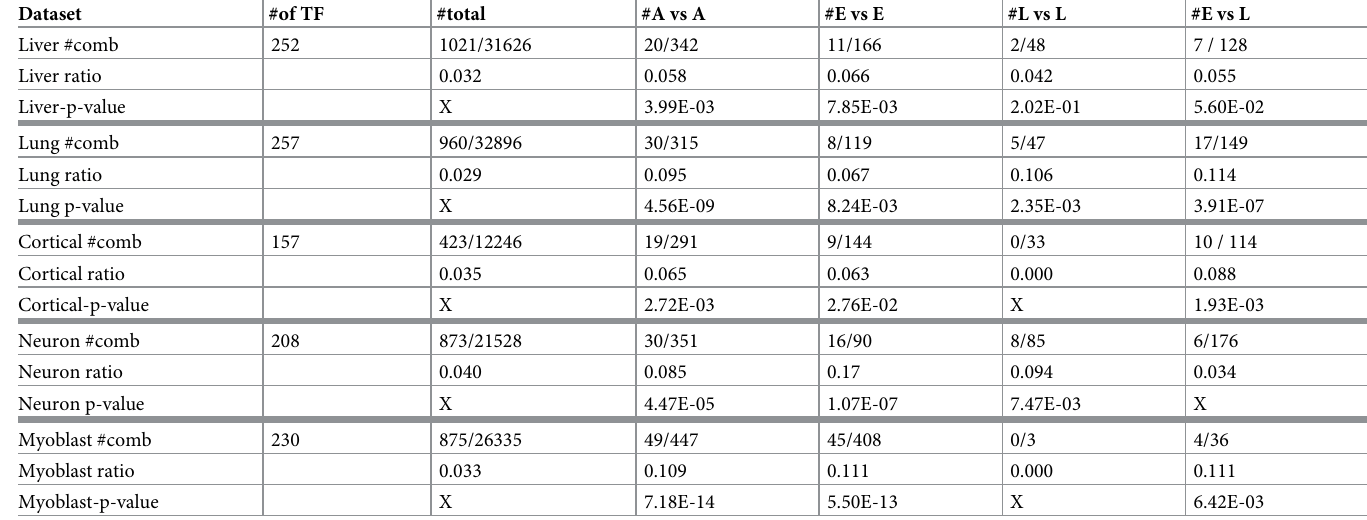
Table 1. Analysis of predicted TF-TF interactions based on the TcoF database. Abbreviations: total: all possible interactions in a dataset, A: all TFs assigned to each path, E: early TFs in each of the paths, L: late TFs. For each dataset we present 3 rows: number of combinations, ratio and